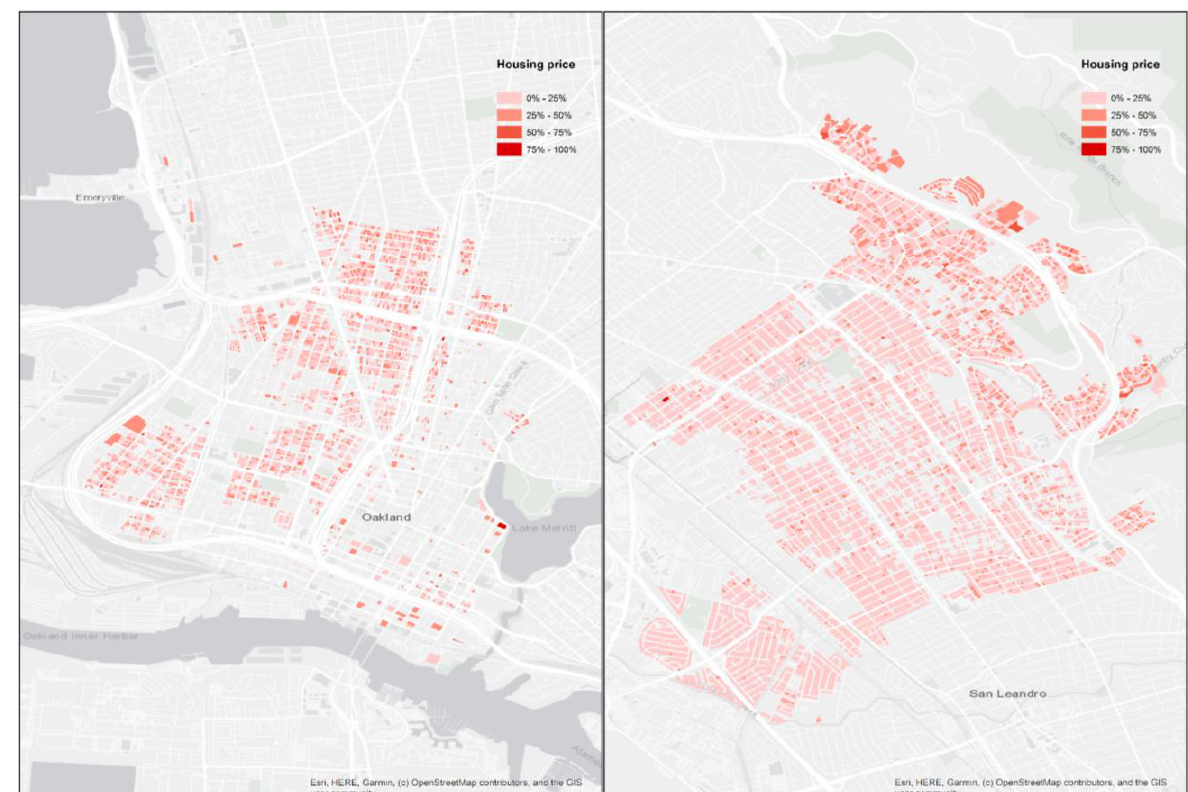
Figure 2. Housing price spatial distribution in the study domain.